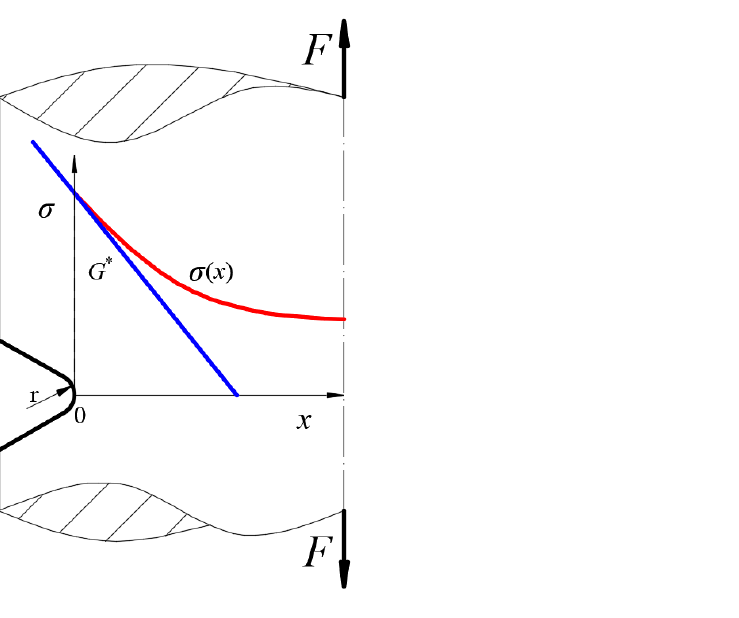
Figure 2. Stress distribution of the notch. The distribution of the stress gradient merely pertains to the shape of the notch, while the stress σ is linearly related to the load F . To eliminate the influence of load F on the stress gradient G and also to facilitate the comparison of stress gradients of notches of different shapes, the relative stress gradient χ is proposed, as shown in Equation (2).